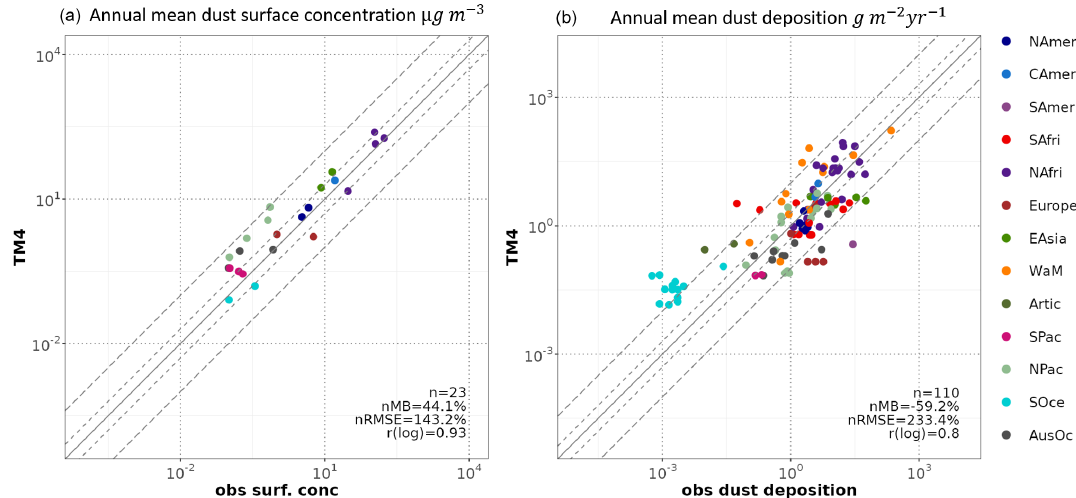
Figure 3. Comparison of (a) the modeled annual mean dust surface concentration for the years 2009–2016 against climatological mean values from RSMAS sites and AMMA campaign, and (b) modeled annual dust deposition flux averaged for the same period against observations compiled in Albani et al. (2014) from several sources. The solid line represents the 1 : 1 correspondence, the long dashed lines show the 10 : 1 and 1 : 10 relationships, and short dashed lines correspond to a factor of 2, respectively. Colors indicate measurement locations listed in the figure